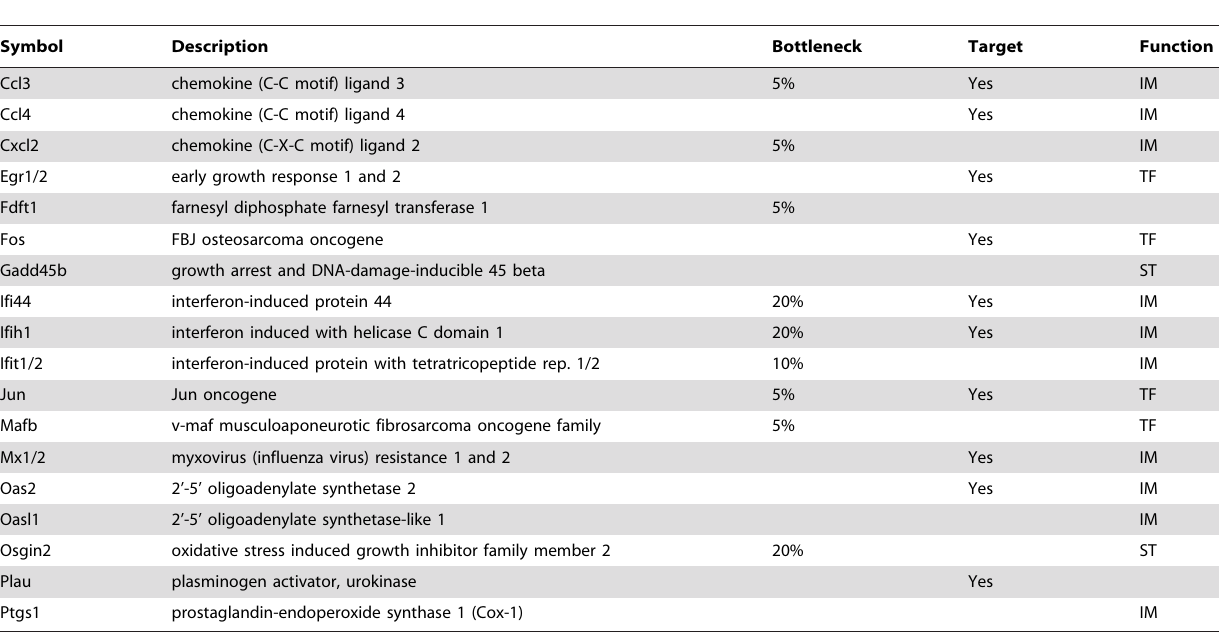
Table 1. Members of the macrophage core response